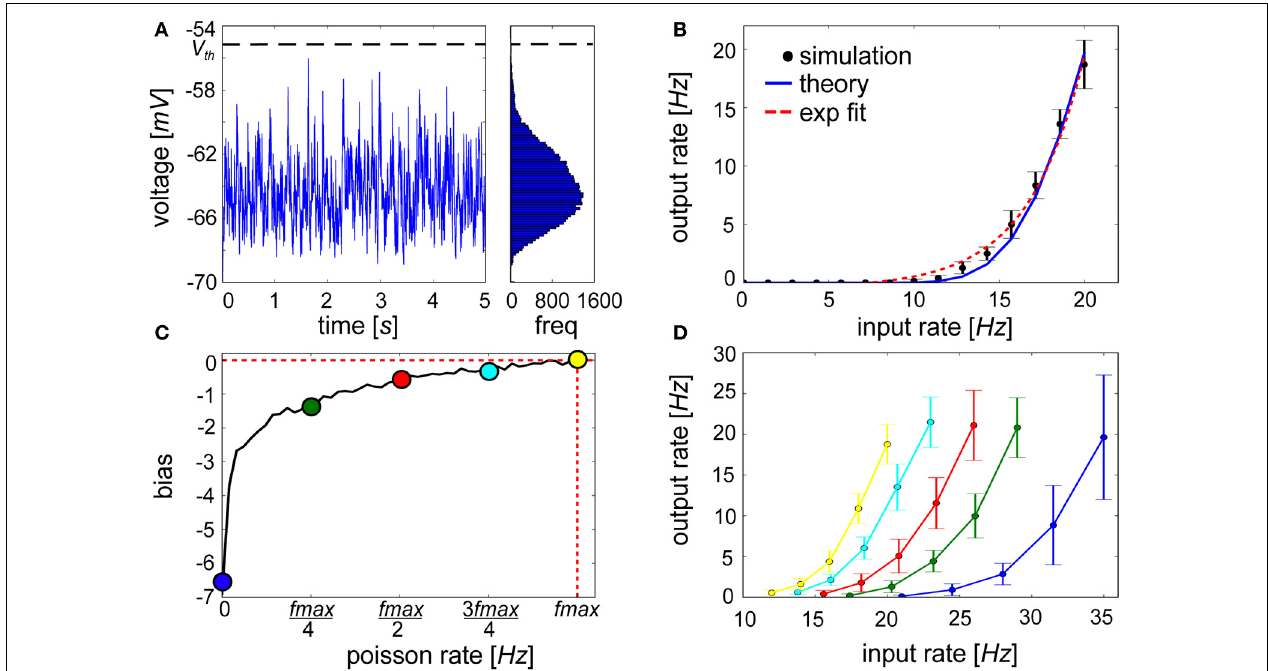
FIGURE 8 | Exponential activation function of a lowly firing IAF neuron is shifted by an injection of a hyperpolarizing current proportional to β j . (A) Voltage trace and resulting long tail distribution of a membrane potential histogram from an IAF neuron approaching firing threshold of − 55mV (bin size = 0.15mV). (B) The input-output curve of an IAF neuron with 30 inputs each firing at values listed along the abscissa (black, simulated; blue, see Materials and Methods for theoretical IAF rate). For low firing frequencies at or below 20Hz, the